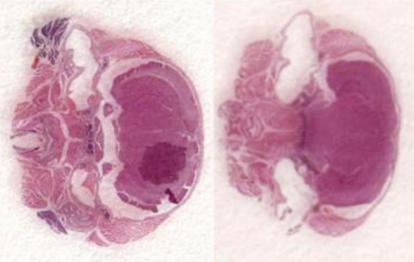
Glioblastoma in treated (right) and control (left) animals